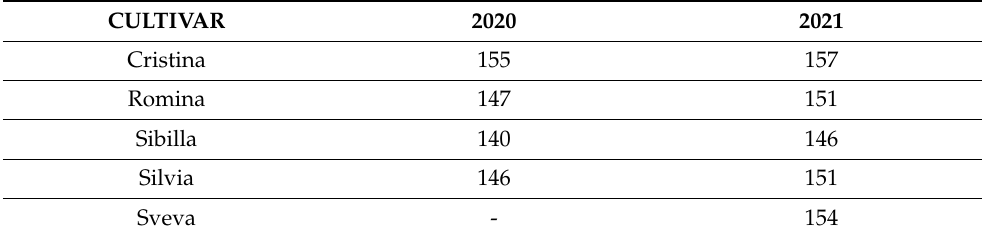
Table 1. Precocity index (PI) of the strawberry cultivars for the years 2020 and 2021.